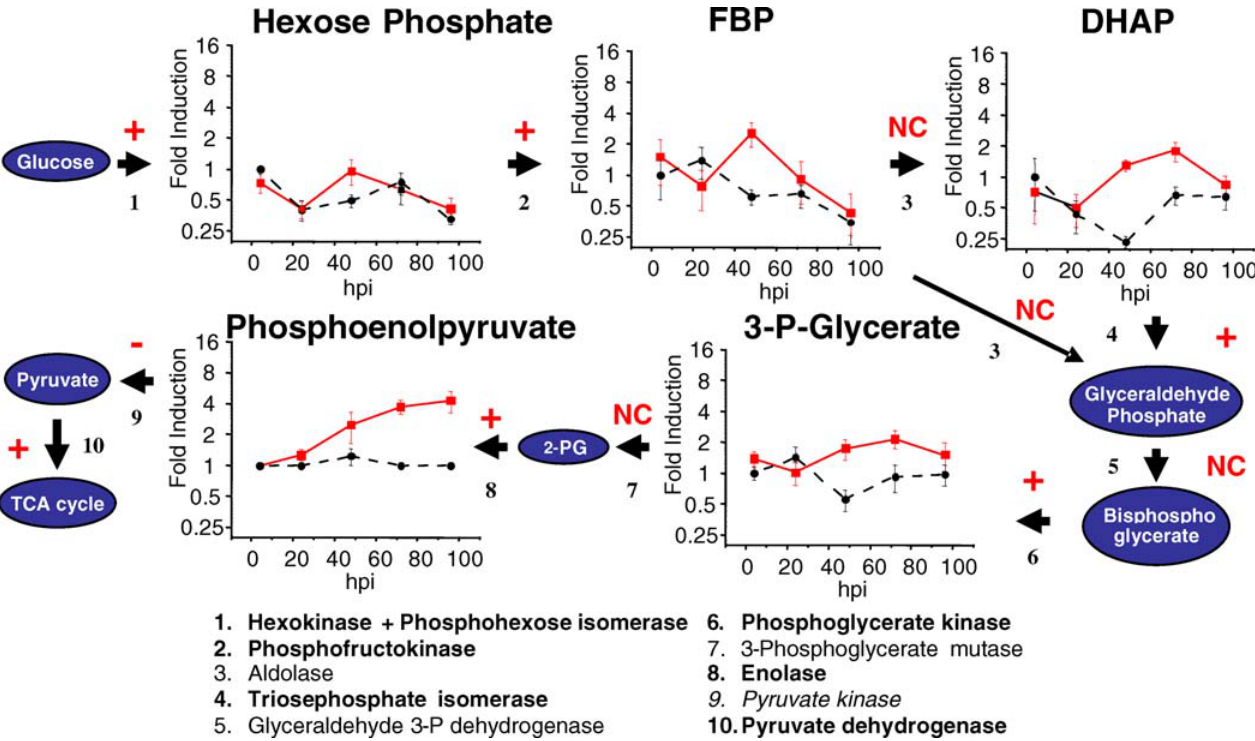
Figure 1. HCMV-Induced Changes in Glycolytic Metabolites Replicate cultures of confluent fibroblasts were serum-starved for 24 h and subsequently mock- infected (dotted line) or virally infected at a multiplicity of 3.0 pfu/cell with HCMV (red line). Cells were harvested at 4, 24, 48, 72, and 96 hpi and processed for LC-MS/MS. SRM peak heights from two independent experiments performed in duplicate ( n ¼ 4) were normalized to protein levels. Average fold change in the metabolite level (relative to the mock 4-h sample) is plotted on a log 2 axis. Error bars show 6 1 SE of the mean. Transcriptional data are depicted graphically at the relevant enzymatic step by the following symbols (shown in red): þ , increased and (cid:1) , decreased (cid:2) 1.5-fold in HCMV infection versus mock infection and p , 0.05 based on ANOVA analysis; NC, no change, either not significant by ANOVA or effect of HCMV , 1.5-fold. Enzyme names are also provided, with those increased transcriptionally listed in bold and those decreased in italics. Transcriptional data represent an average across 24, 48, and 72 h and specific enzyme